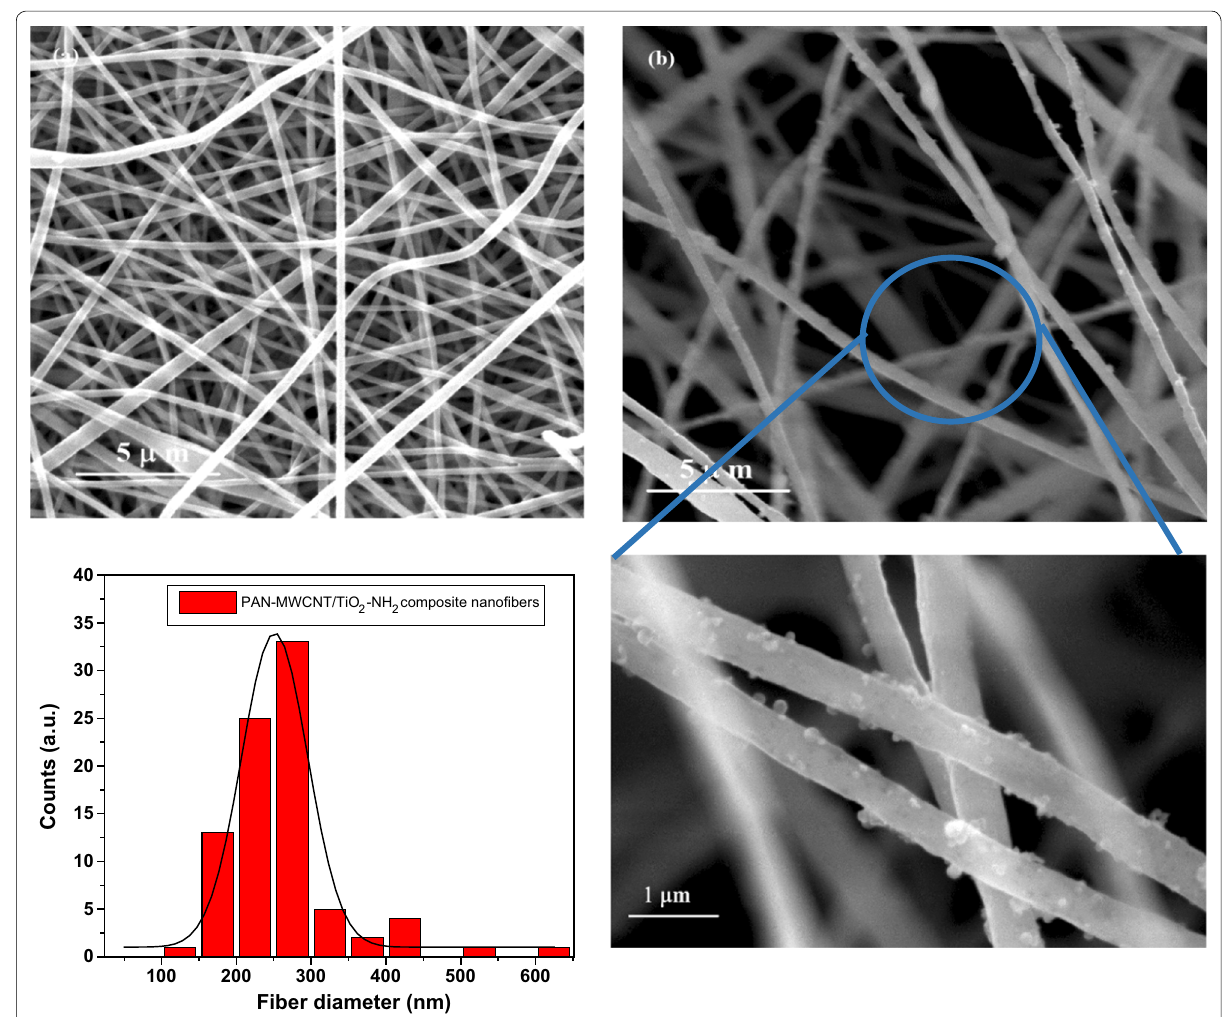
Fig. 6 SEM of a PAN nanofibers and b PAN-MWCNT/TiO 2 –NH 2 composite